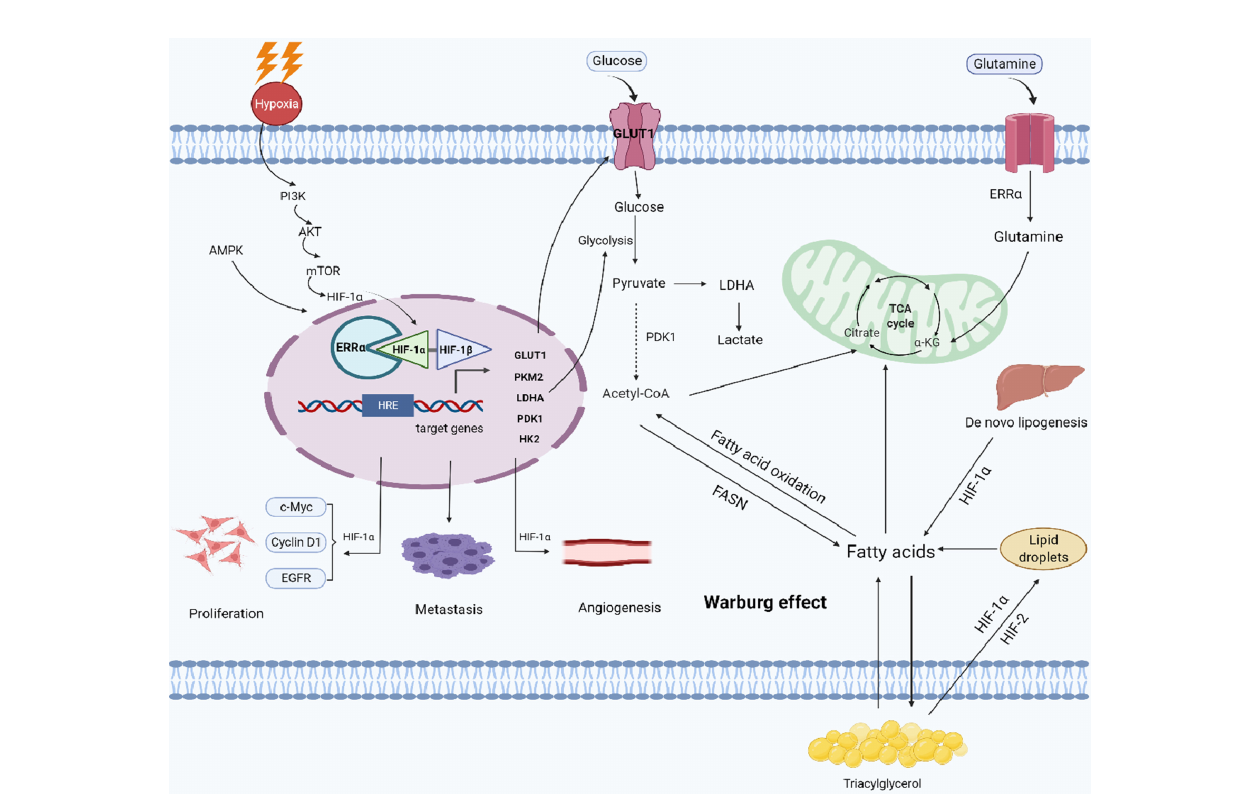
FIGURE 1 | Working model of the role of HIF-1 a /ERR a in cancer cell metabolism. Cancer cells can adapt to low oxygen conditions through the PI3K/AKT/mTOR and AMPK signaling pathways, which regulate metabolic reprogramming. ERR a interacts with HIF-1 a , enhancing the transcriptional activity of HIF-1 a and promoting the remodeling of glucose and lipid metabolism (formation of lipid droplets) in cancer cells. ERR a also enhances glutamine metabolism and lipid de novo synthesis, promoting metabolic adaptation in cancer cells. Together, these activities stimulate tumor proliferation, metastasis, and angiogenesis. Images were made in BioRender